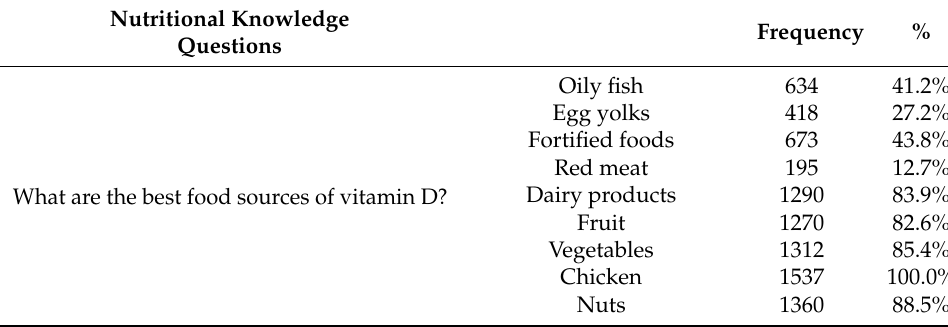
Table A2. Nutritional knowledge of vitamin D ( n = 1537)—Individual